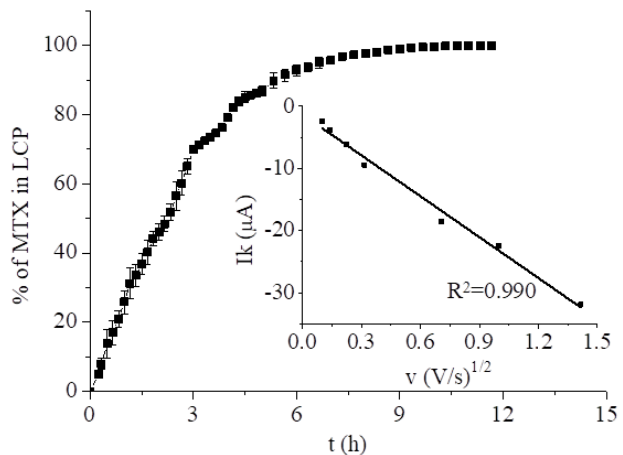
Figure 2. Saturation of LCP with the drug from 2.33 mM MTX solution in 0.2 M phosphate buffer monitored by SWV. Inset: Dependence of the CV reduction peak current at −0.790 V vs. the square root of the scan rate for the cubic phase layer phase with MTX after 12 h of saturation.